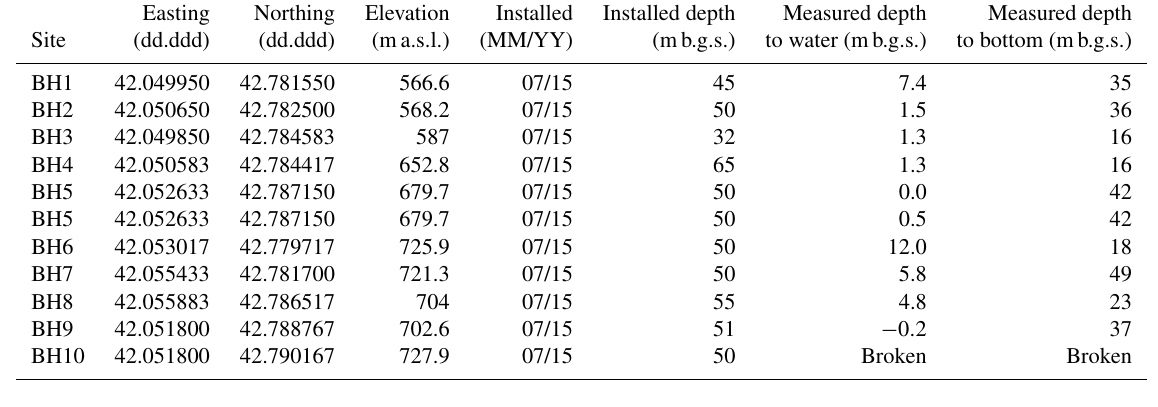
Table 2. Location of measured piezometers and water table depth; b.g.s. refers to depths below ground surface.